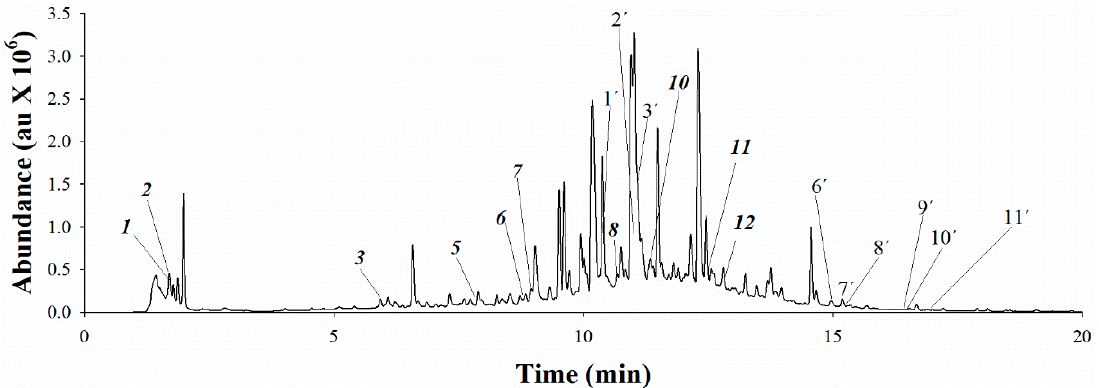
Figure 1. Chromatogram of concentrate of Buddleja scordioides infusion at λ = 280 nm, as example of all processing conditions. Label numbers in italics with no quote marks indicate phenolic acids (see Table 3 for number codification of phenolic acids). Label numbers with quote marks indicate flavonoids (see Table 4 for number codification of flavonoids).